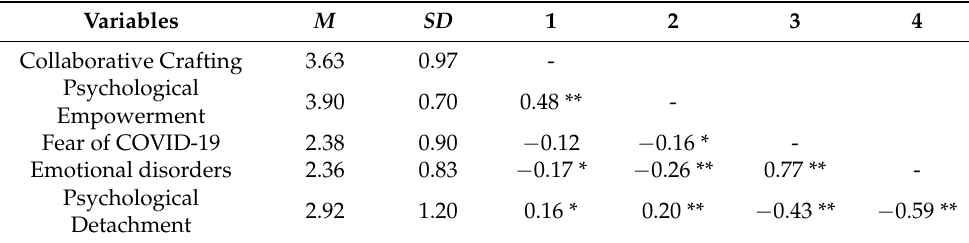
Table 2. Bivariate correlations, means, and standard